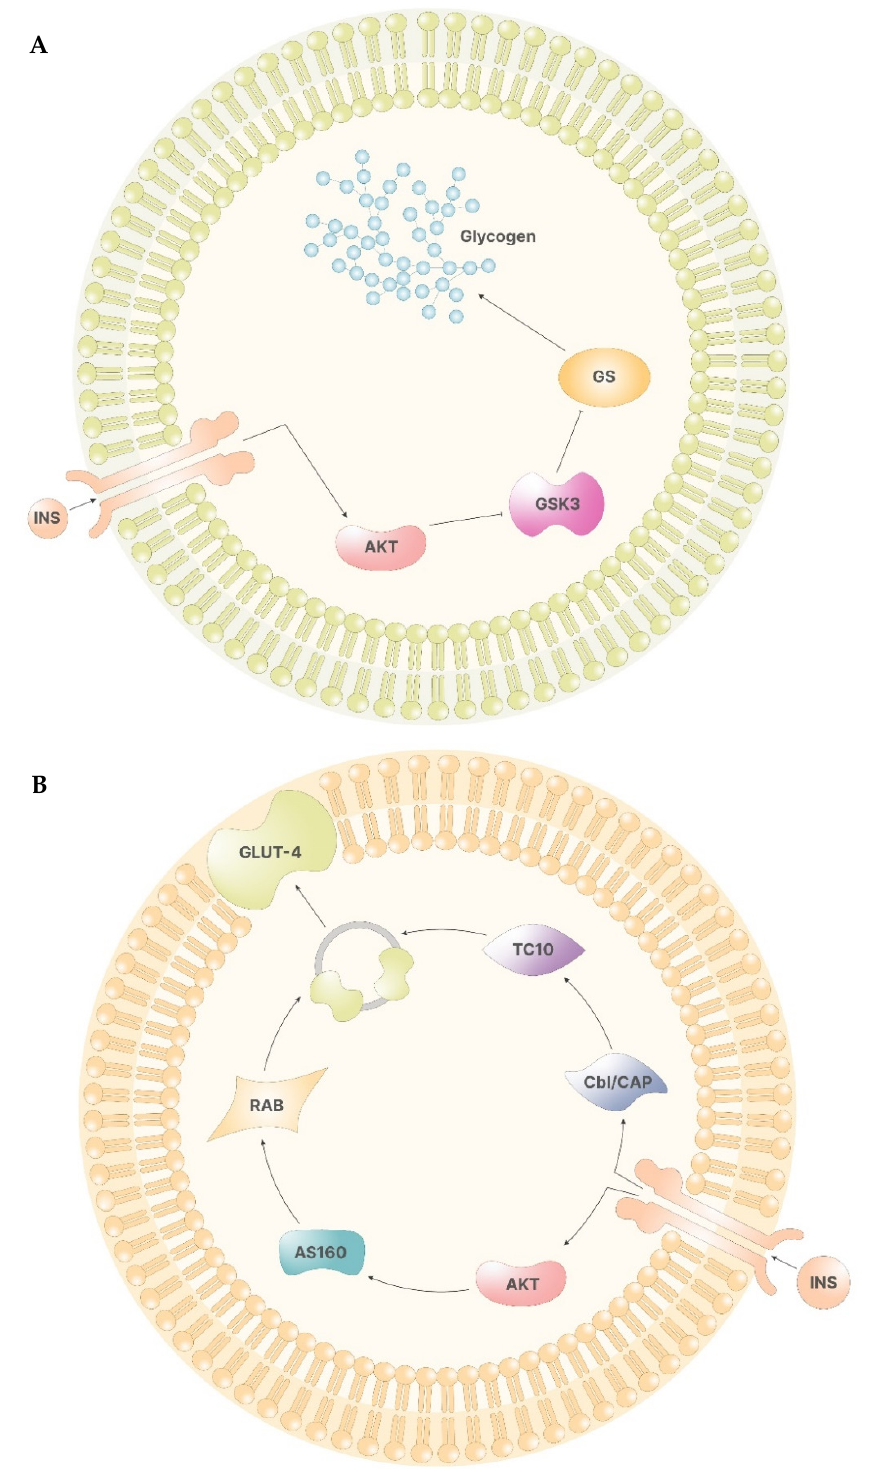
Figure 2. ( A )—The signal of insulin leads to the activation of Akt via PIP3. In the liver cells, Akt inhibits the function of GSK3, which, if functional, would inhibit GS. Therefore, Akt activation leads to glycogen synthesis. ( B )—In non-storage tissues, the activation of Akt enables the activity of AS160. AS160 activates Rab, which, in turn, promotes the formation of GLUT-4 containing vesicles. On the other side, the insulin receptor activates Cbl/CAP complex, which, via TC10, promotes the release of the vesicles containing GLUT-4.